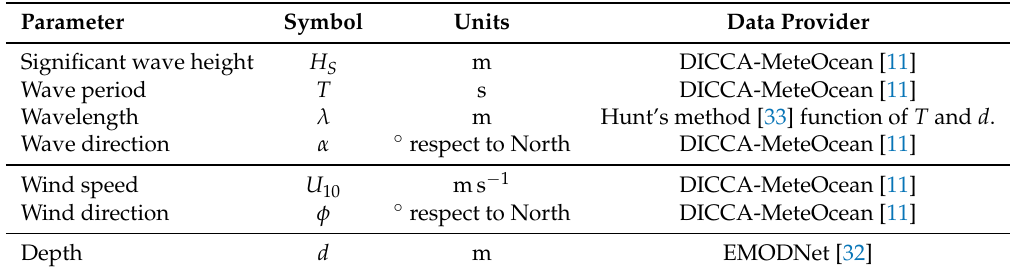
Table 2. Environmental variables retrieved by the Environmental layer from the selected providers.